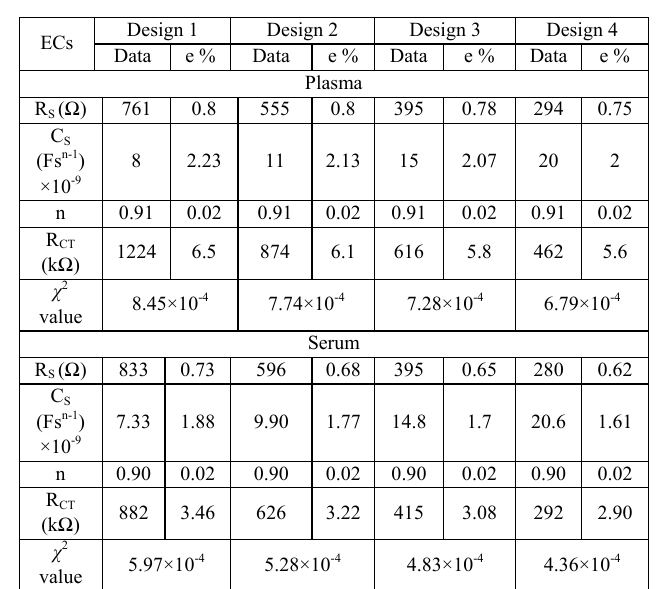
Table 3. Values of electric components of plasma and serum for different designs with relative standard error (e %).